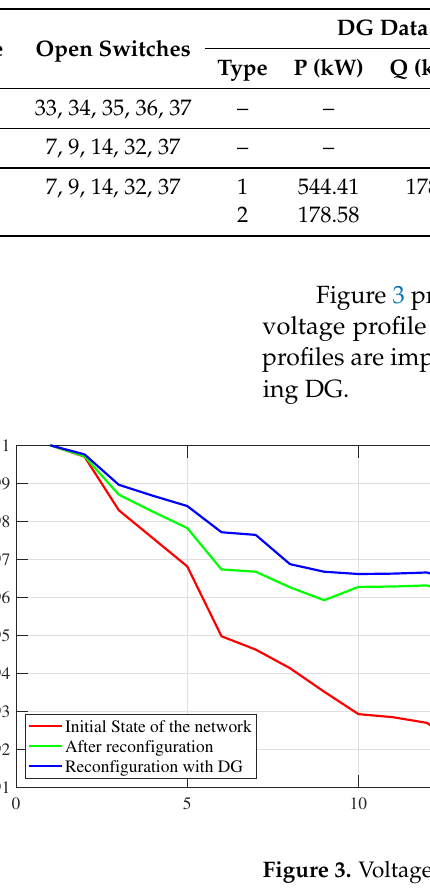
Table 3. Results for the 33-bus test system.